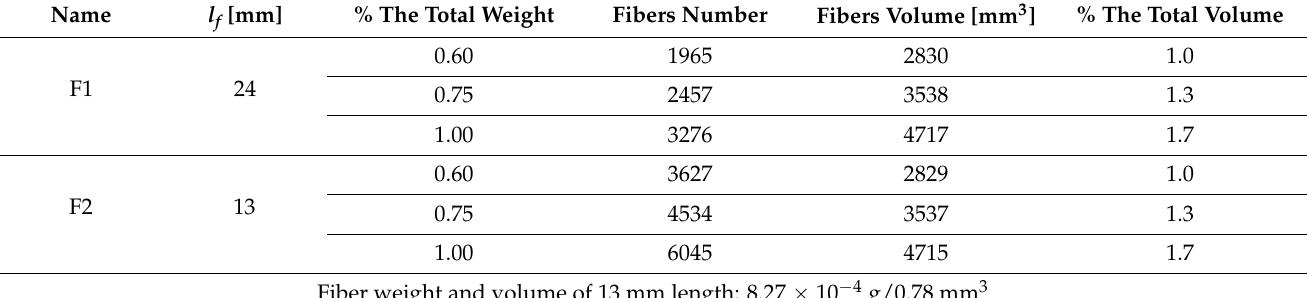
Table 3. Fibers aspect ratio compared with a mortar specimen of dimensions 40 × 40 × 160